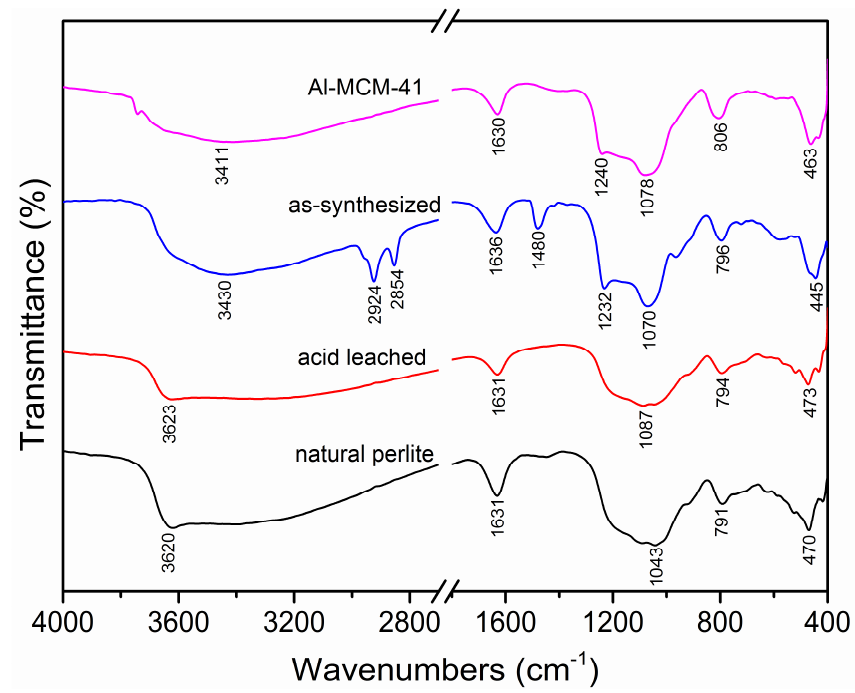
Figure 7. Fourier-transform infrared (FTIR) spectra of samples.